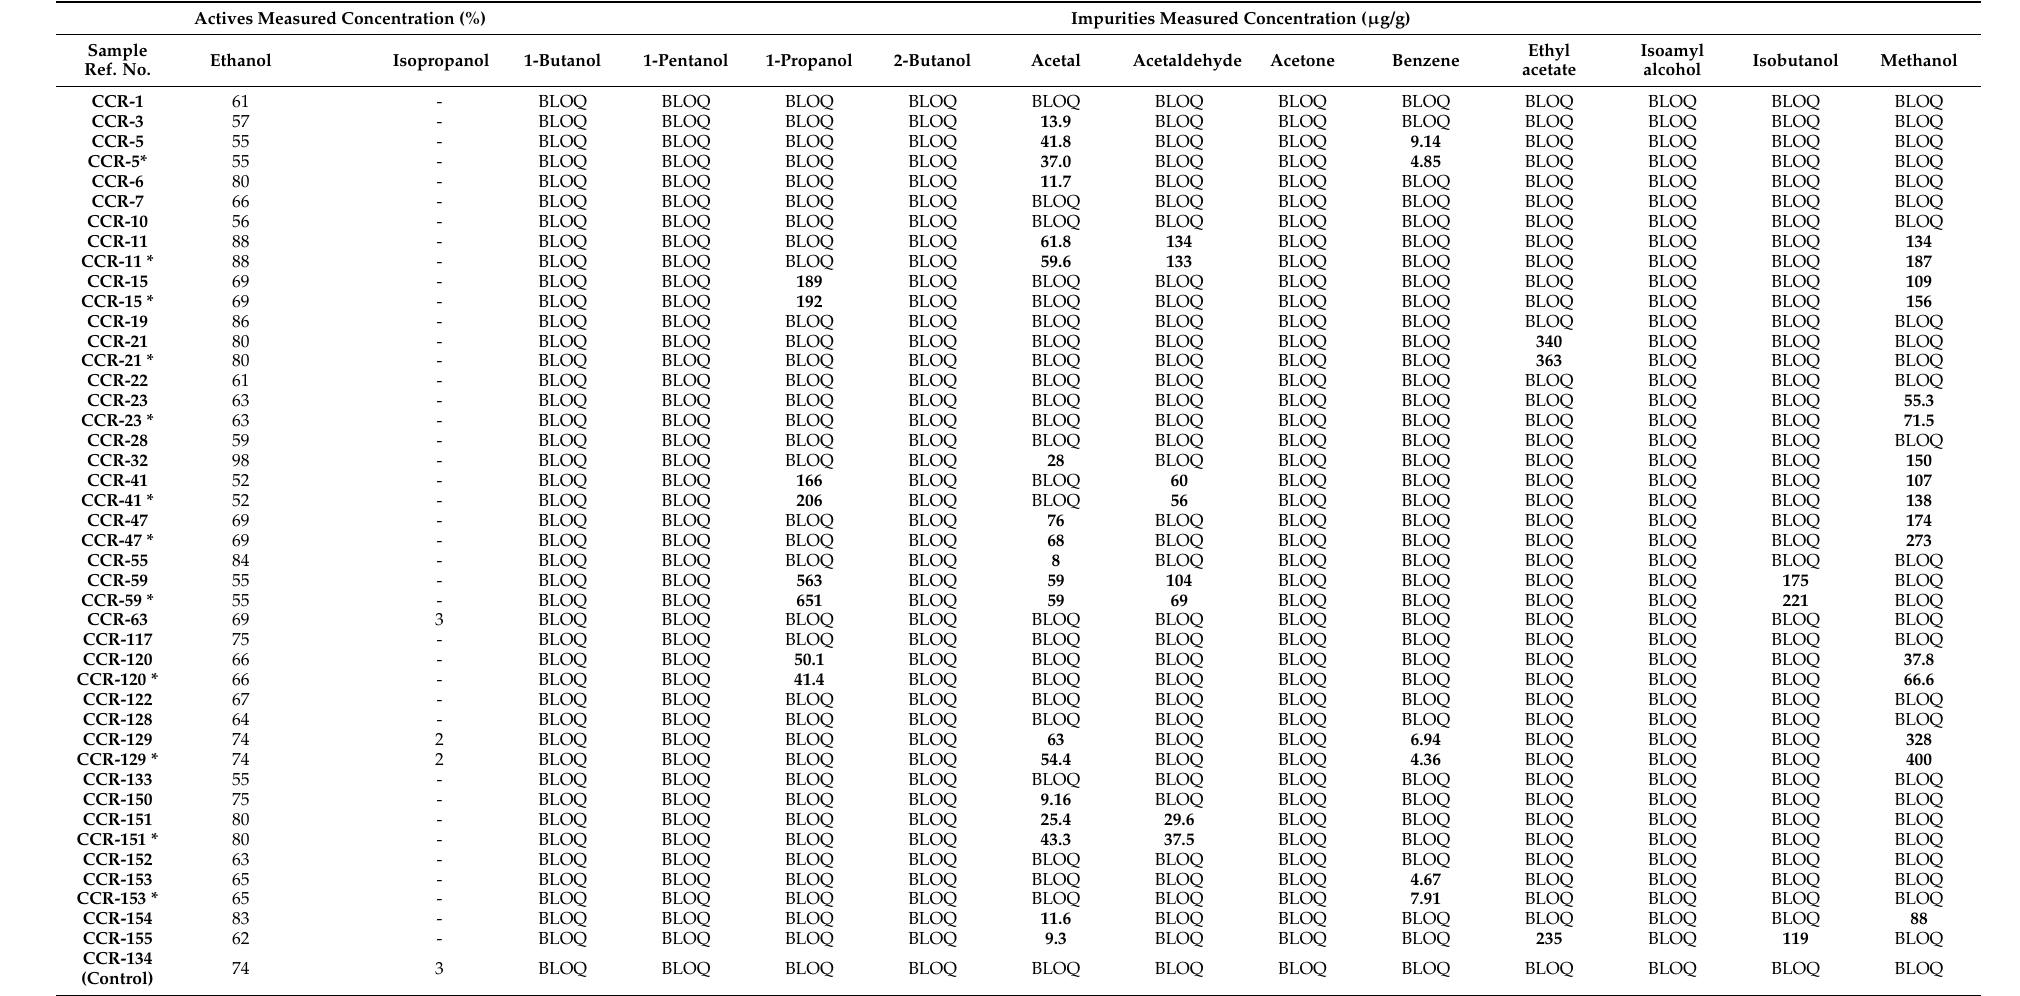
Table 4. Concentrations of Impurities Measured in Selected Hand Sanitizers Marketed to